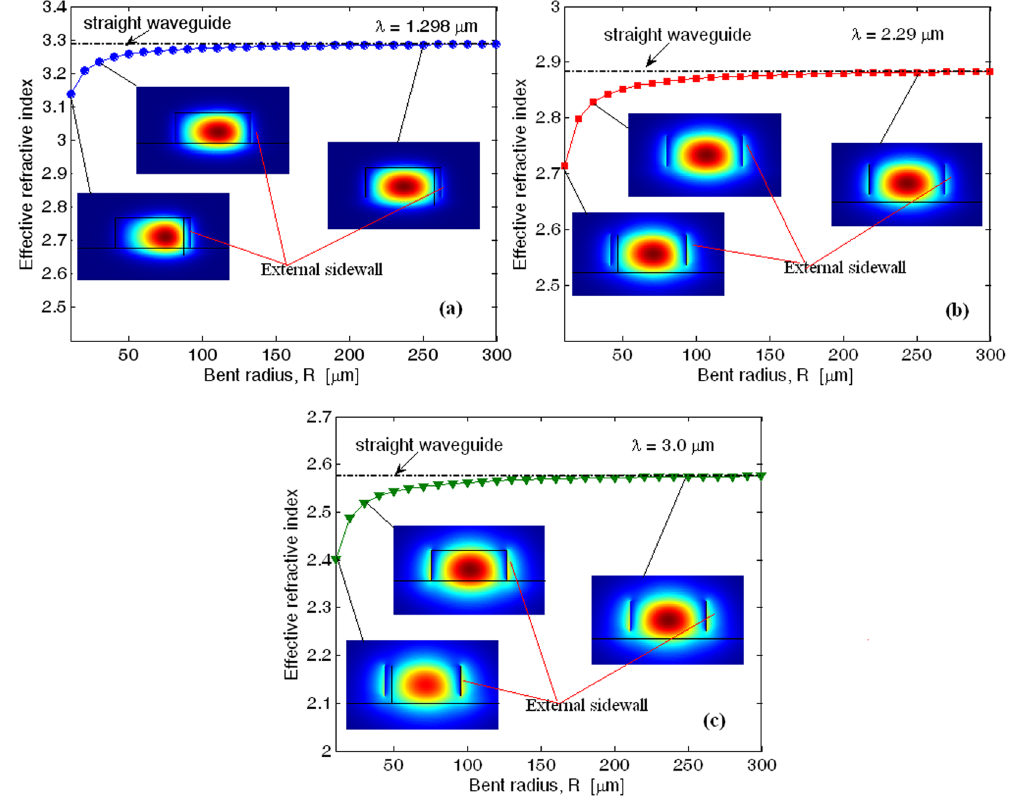
Figure 10. Effective refractive index as a function of the bent radius for the fundamental quasi-TE mode ( a ) at λ = 1.298 µ m; ( b ) at λ = 2.29 µ m; ( c ) at λ = 3 µ m; The insets represent the space distribution of the dominant electric-field component for three different bent radius: R = 10, 30 and 250 µ